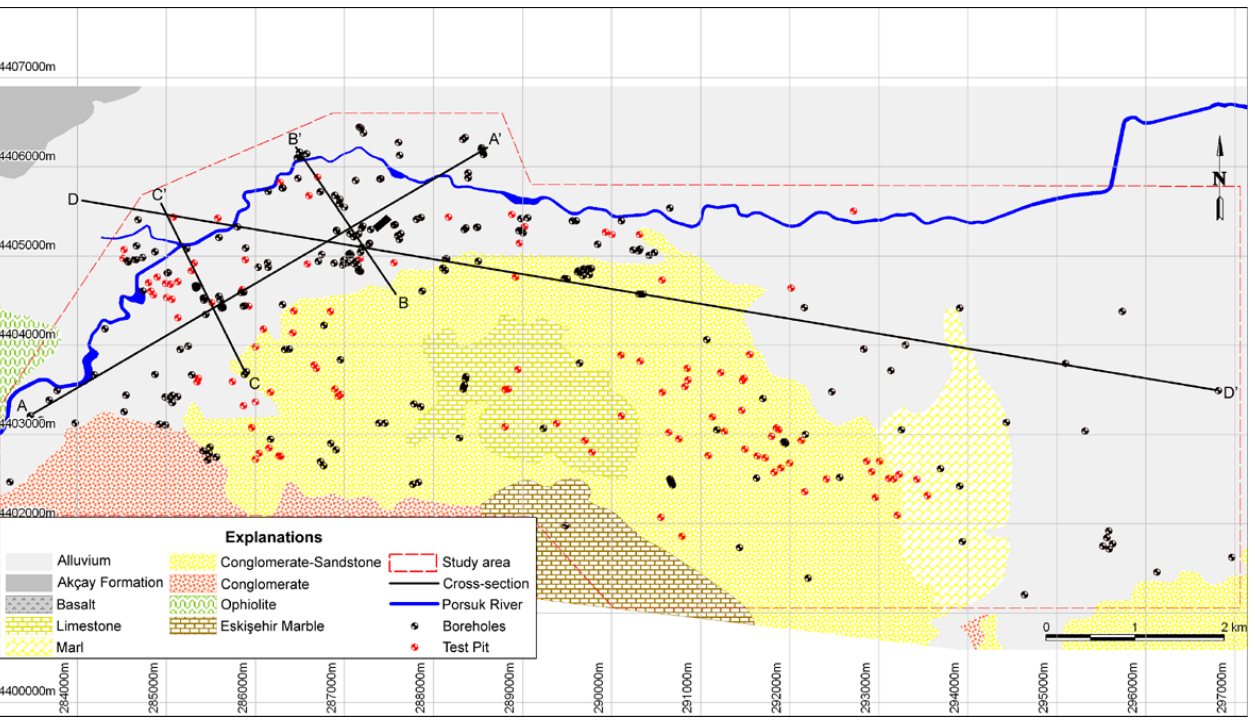
Fig. 5. A general overview of the field